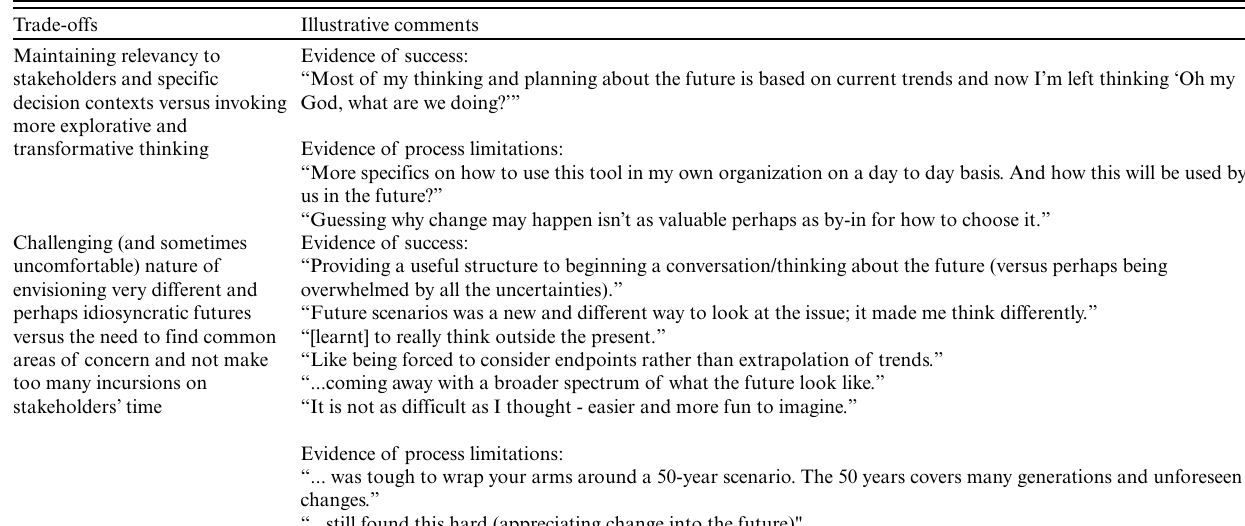
Table 5 . Workshop feedback comments illustrating the successes and limitations of the scenario building process. The trade-offs listed here represent a condensed version of those described in Table